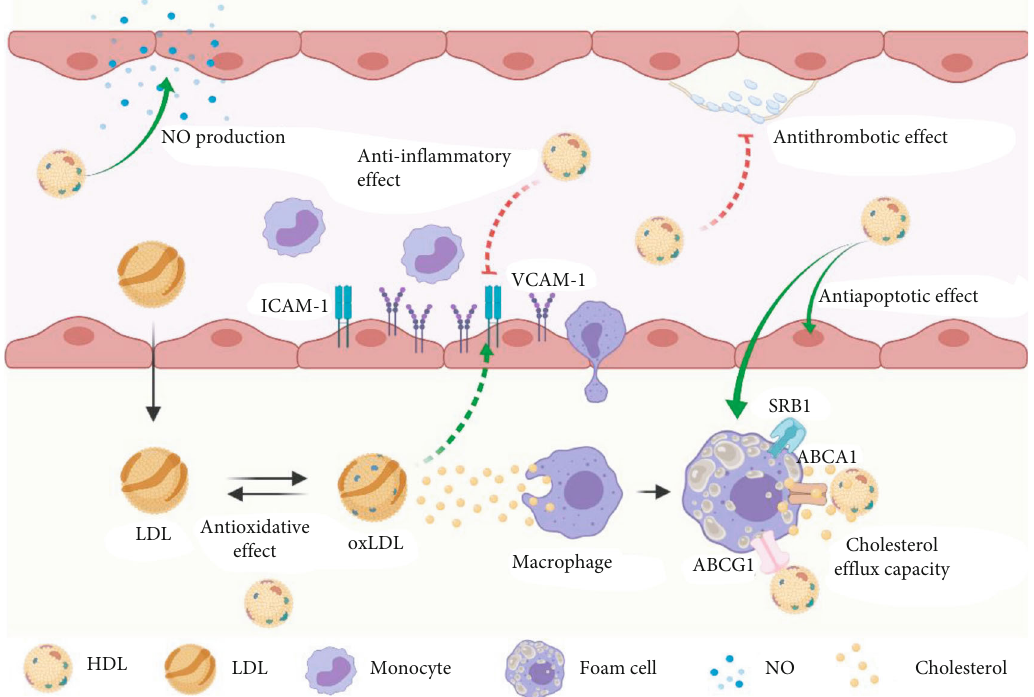
Figure 1: Antiatherogenic functions of HDL. NO: nitric oxide; HDL: high-density lipoprotein; LDL: low-density lipoprotein; oxLDL: oxidized LDL; SR-B1: scavenger receptor B1; ABCA1: ATP-binding cassette transporter A1; ABCG1: ATP-binding cassette transporter G1; ICAM-1: intercellular adhesion molecule 1; VCAM-1: vascular cell adhesion molecule